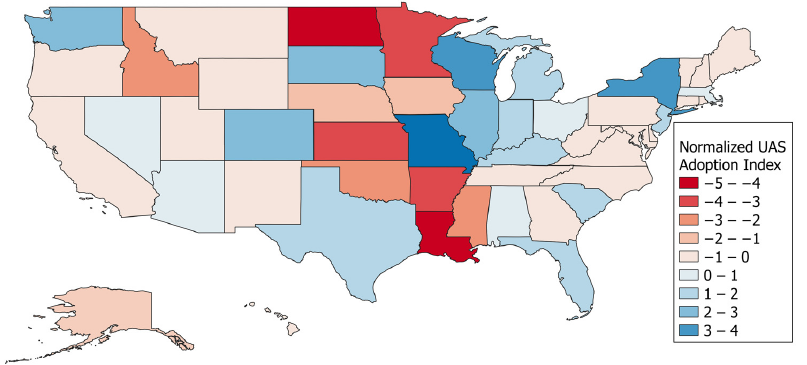
Figure 5. Normalized UAS adoption index across the United States indicates significant regional bias in the adoption of UAS for aerial application.